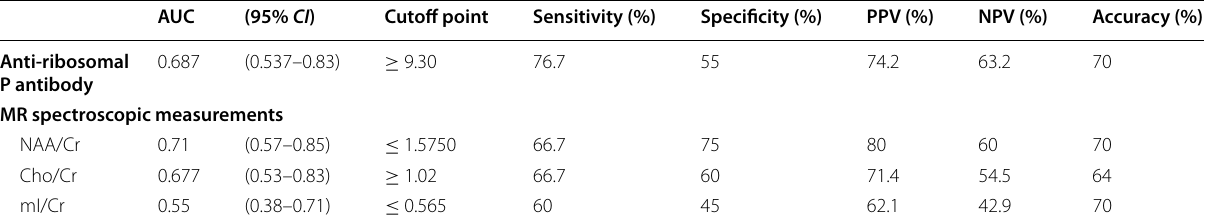
Table 5 Validity of anti‑ribosomal P antibody and MR spectroscopic measurements in posterior cingulate gyrus in differentiating between active and inactive SLE patients